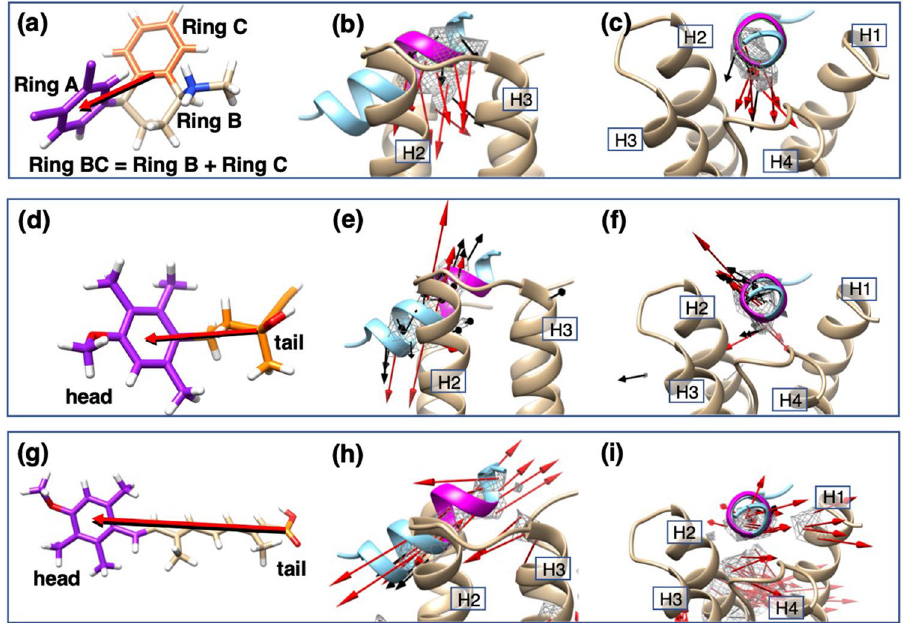
Figure 6. ( a ) A snapshot of sertraline, where three rings, Ring A, B, and C are defined and Rings B and C are unified as Ring BC. Ligand’s orientation (red-colored arrow) is defined by an arrow pointing from the geometric e ( sertraline ) ( r ) center of Ring BC to that of Ring A. Panels ( b ) and ( c ) illustrate spatial patterns of in the cleft (cid:31) (cid:30) e ( sertraline ) ( r ) of mSin3B viewed from two different directions. The vectors are assigned to high-density (cid:31) (cid:30) ( sertraline ) ( r ) > 0.5 ρ 0 ( ρ 0 = 0.001 ) presented by gray contours. Red and black vectors are those with regions of ρ CG e ( sertraline ) ( r ) < 0.5 , respectively. This figure also displays REST/NRSF bound (cid:29)(cid:31) (cid:31) (cid:31)(cid:30) to mSin3B (PDB ID: 2CZY), and the magenta-colored segment is the LIML sequence of REST/NRSF. Note that REST/NRSF is not involved in the current simulation. Labels H1,…, H4 are helices 1,…, 4 of mSin3B (PAH1 domain). ( d ) A snapshot of YN3, where “head” and “tail” are colored by purple and orange, respectively. Red- colored arrow is the YN3’s orientation pointing from the geometric center of tail to that of head. Panels ( e ) and e ( YN3 ) ( r ) e ( YN3 ) ( r ) ( f ) illustrate spatial patterns of . See captions for panels ( b ) and ( c ) for method to draw (cid:31) (cid:30) (cid:31) (cid:30) from two different directions. ( g ) A snapshot of acitretin, where “head” and “tail” are colored by purple and orange, respectively. Red-colored arrow is the acitretin’s orientation pointing from the geometric center of tail e ( acitretin ) ( r ) to that of head. Panels ( h ) and ( i ) illustrate spatial patterns of from two different directions. See (cid:31) (cid:30)